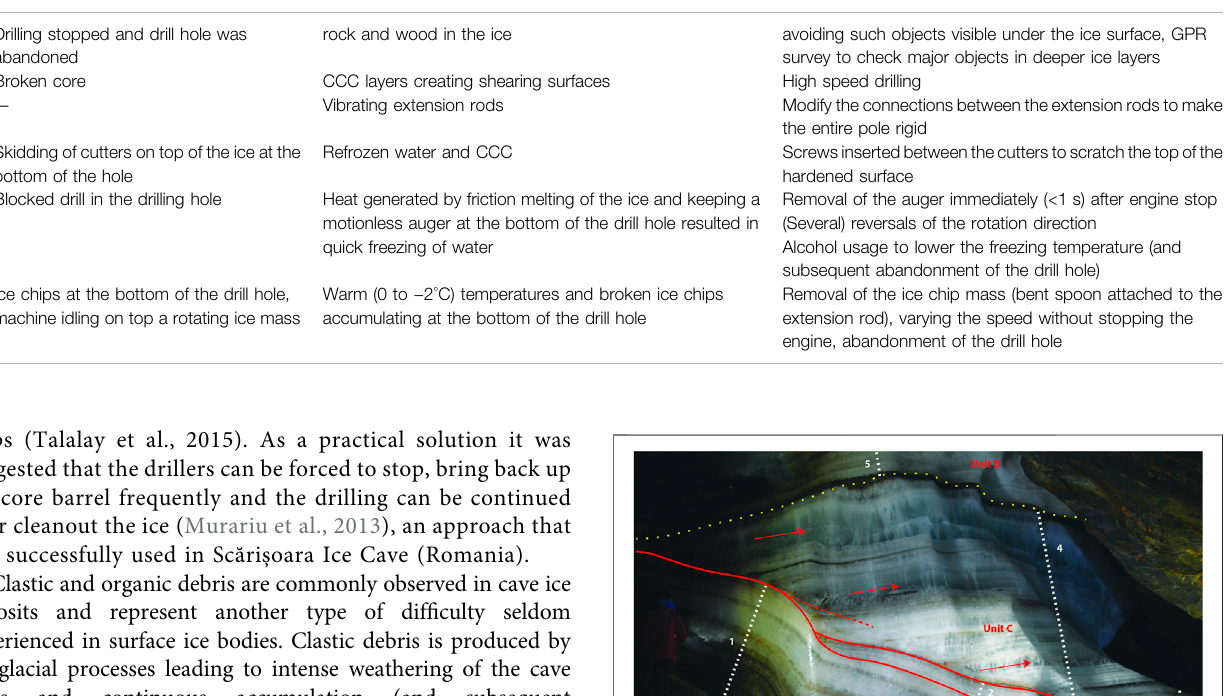
TABLE 2 | The main problems and solutions in ice core drilling in cave environment. Problem